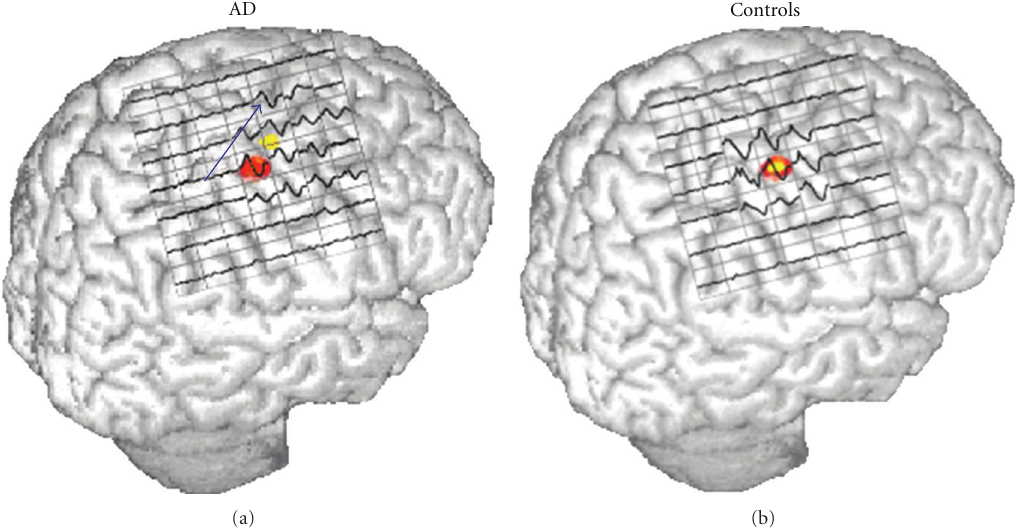
Figure 2: In AD patients is present a significant frontomedial shift of the center of gravity of MI output. In fact, comparing AD (a) and Controls (b) cortical maps how the hot-spot (red area) is not coincident with the center of gravity (yellow area) is evident (modified from [5]). Table 2: Motor cortex excitability parameters trend in patients examined. T 1 : basal evaluation, T 2 : 1 year after AchE-ib treatment,